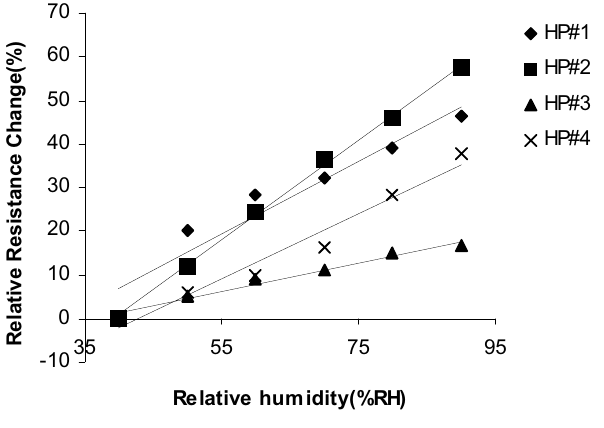
Figure 13. Humidity Sensitivity Curves for In 30 o C.